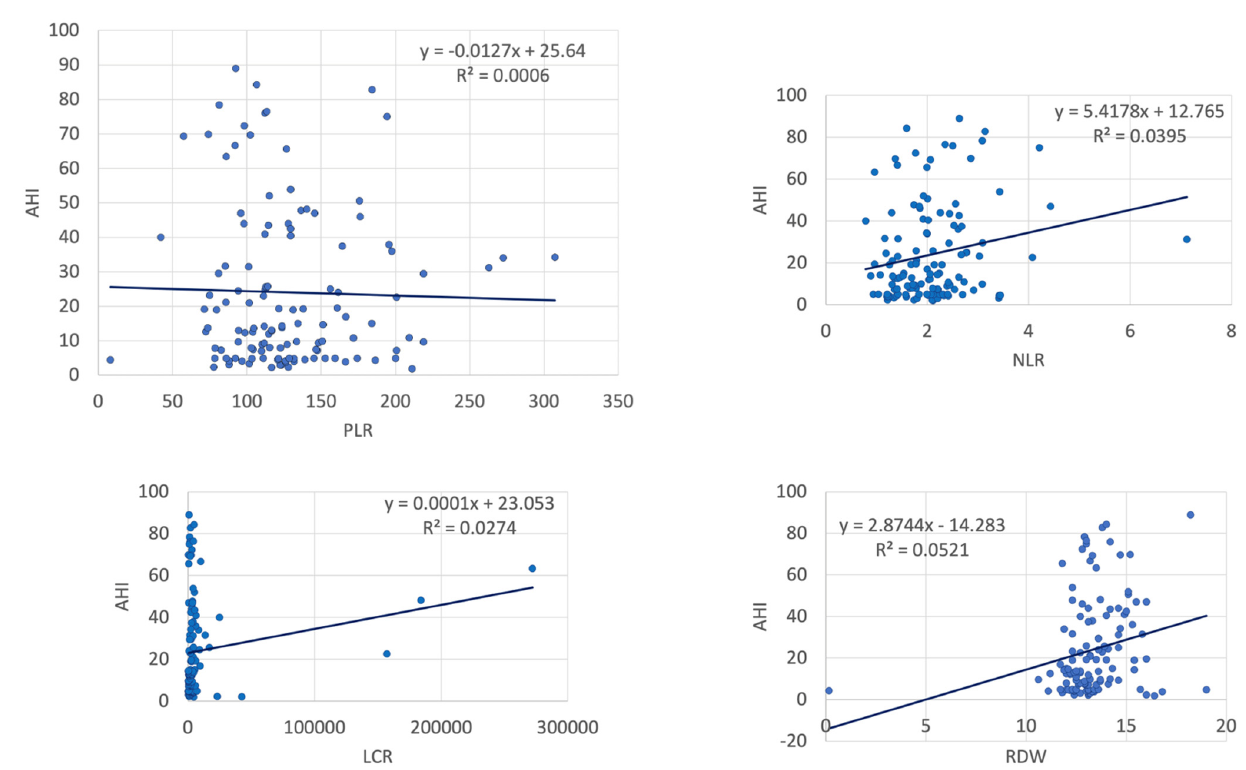
Figure 1. Correlations between AHI and inflammatory markers (123 patients, controls and OSA)